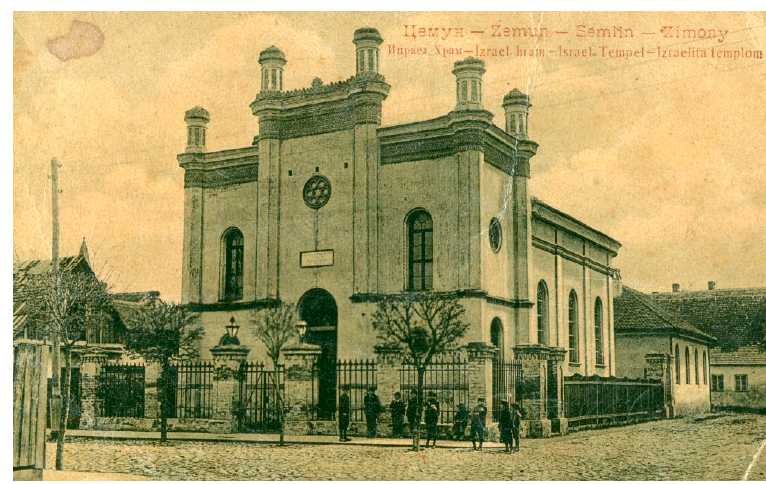
Figure 12. Josef Marks’ Sephardi synagogue, Zemun 1871.